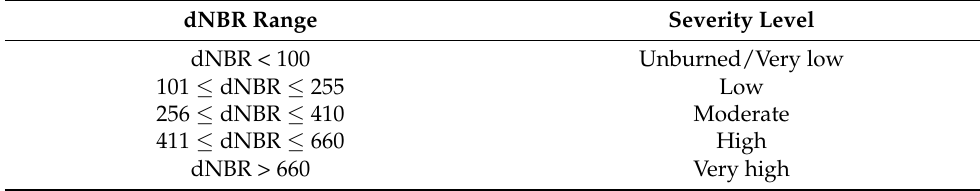
Table 1. Burn severity levels proposed by the